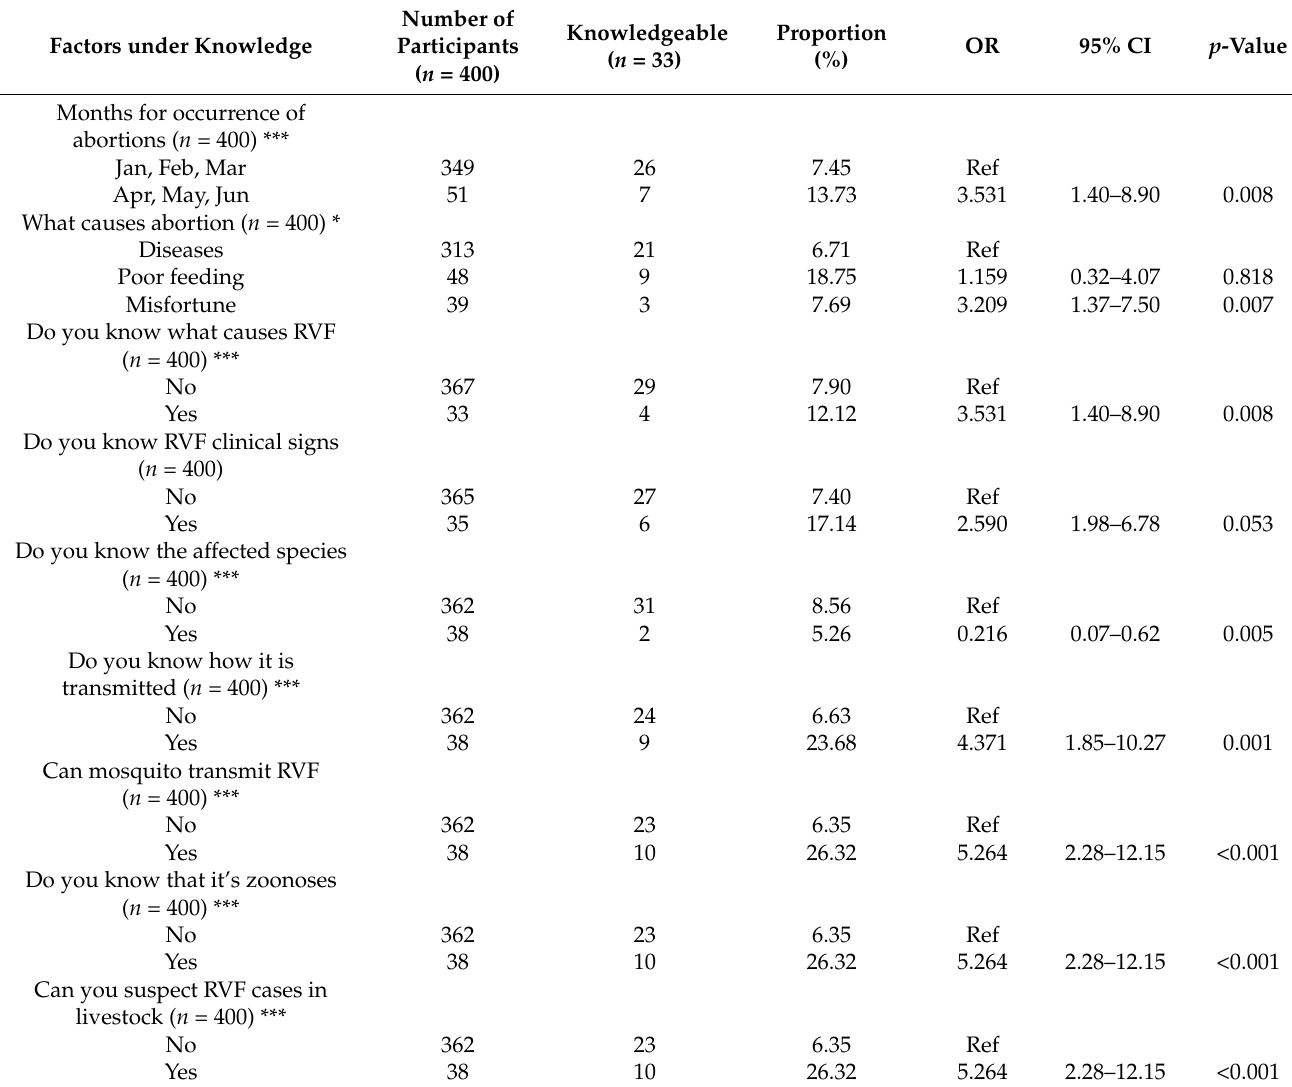
Table 6. Summary of univariate regression analysis of potential predictors within the knowledge category and the observed level of knowledge for RVF.